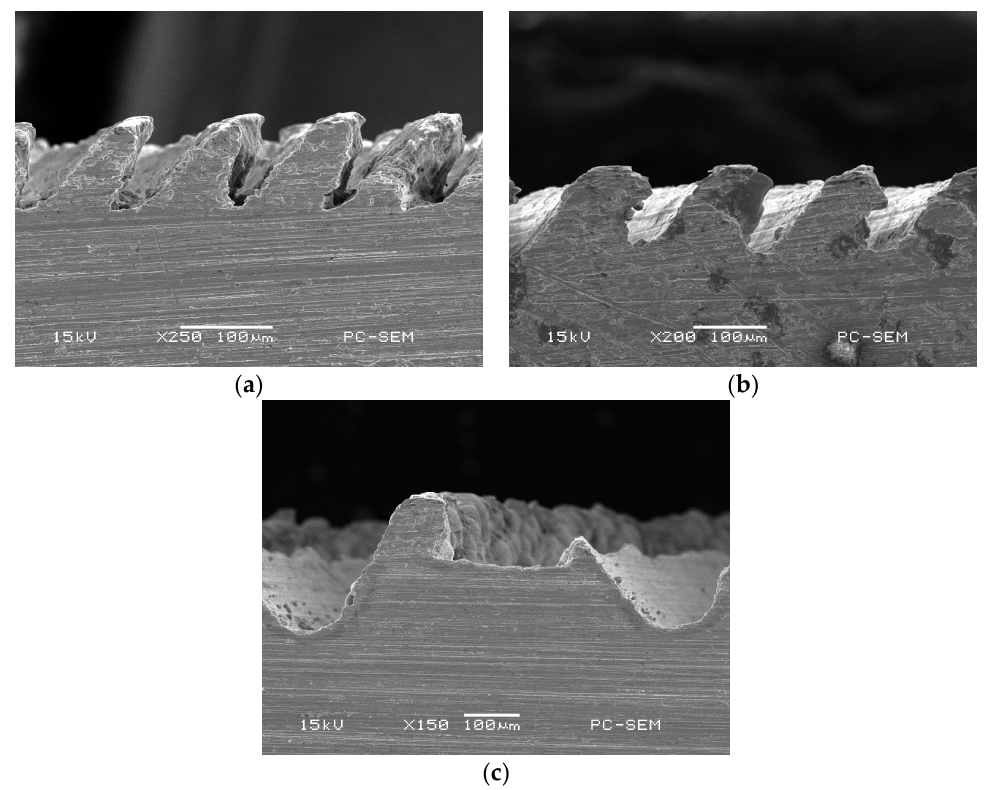
Figure 13. SEM section images of microgrooves under different d ph in experiment. ( a ) a ph = 0.1 mm, d ph = 0.21 mm; ( b ) a ph = 0.1 mm, d ph = 0.31 mm; ( c ) a ph = 0.1 mm, d ph = 1.24 mm.